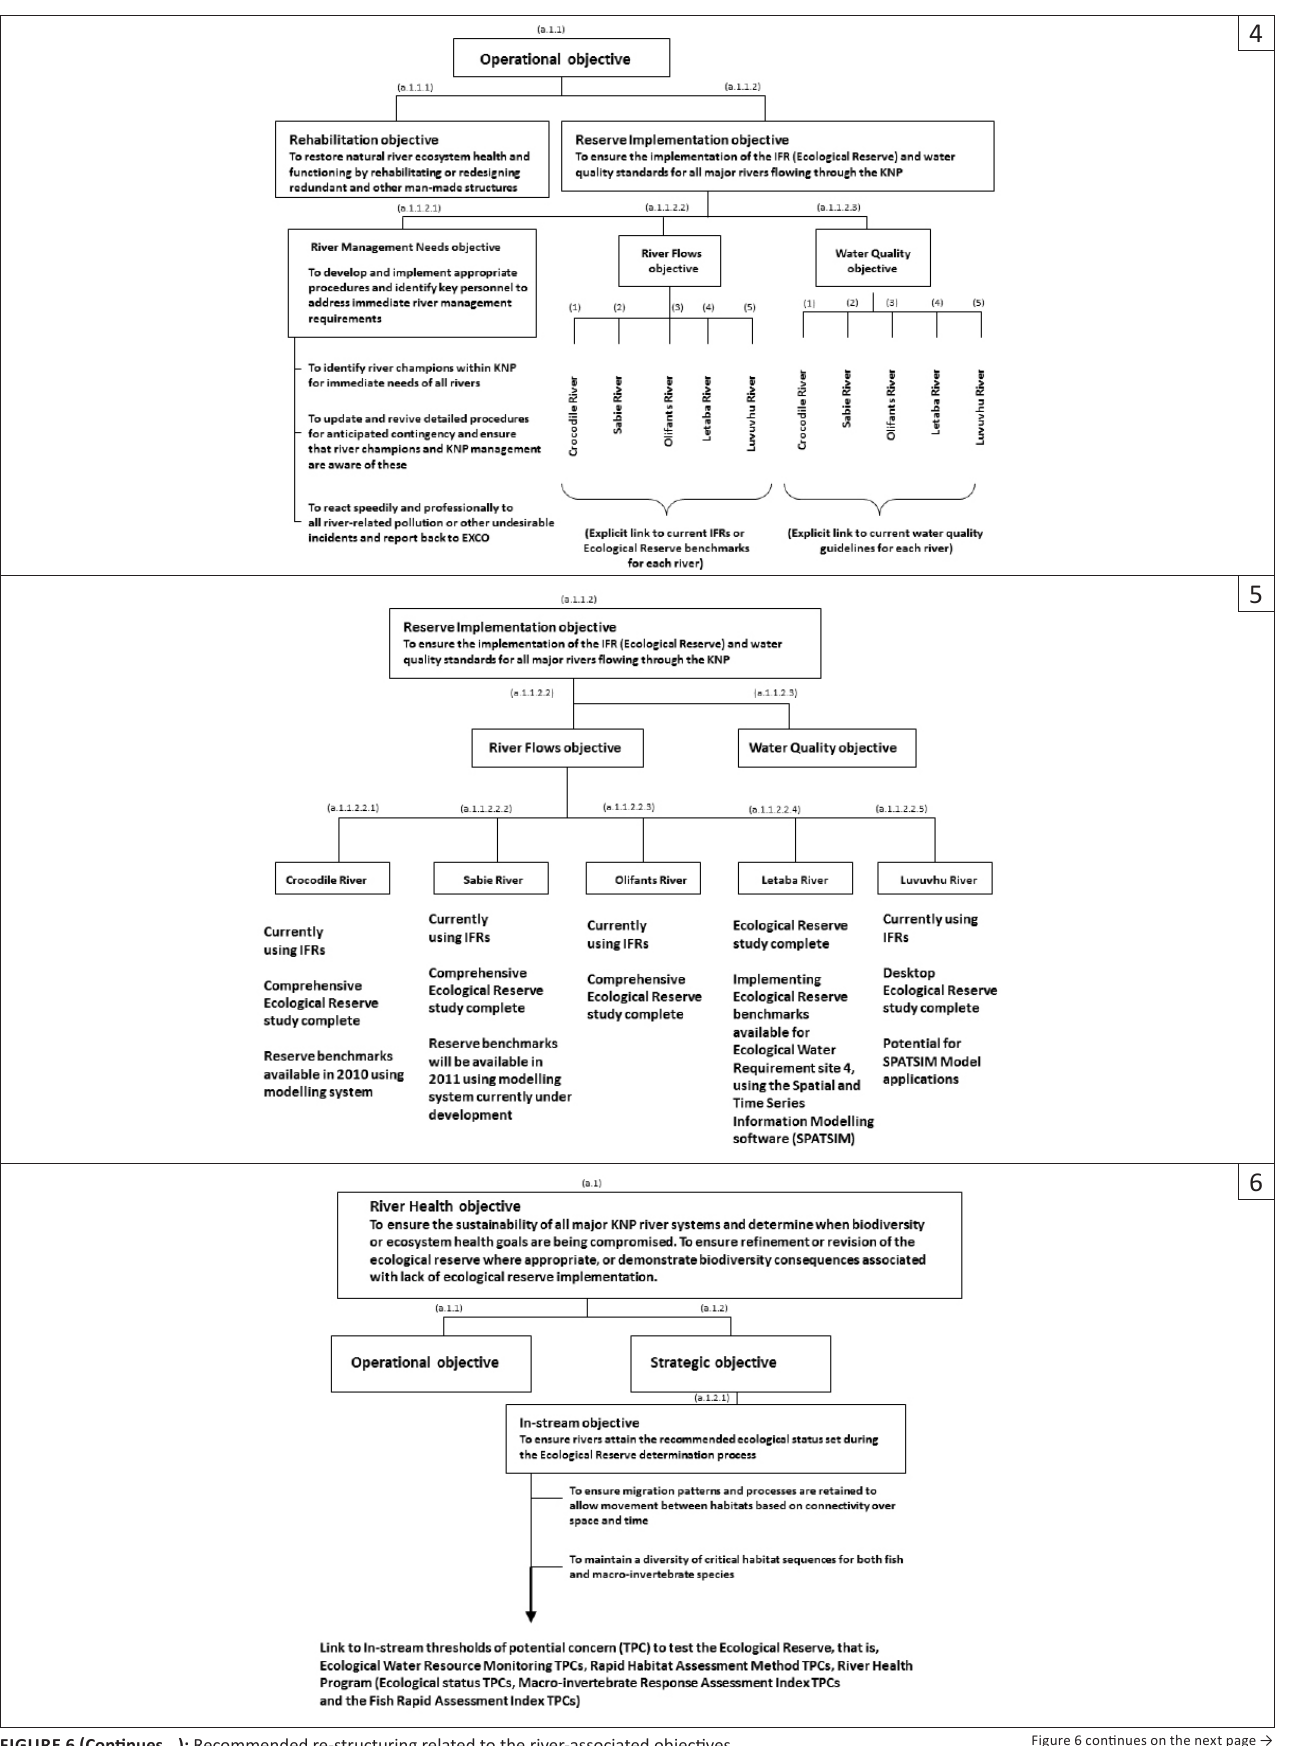
FIGURE 6 (Continues...): Recommended re-structuring related to the river-associated objectives. Figure 6 continues on the next page